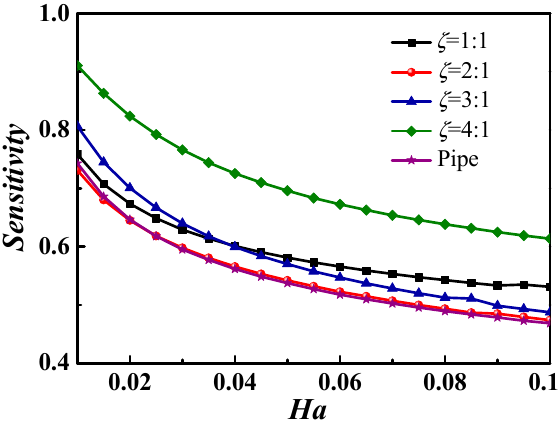
Figure 10. Sensitivity of the Vb number to the Nu number with various cross-sections. 3.4.3. Sensitivity Analysis of the Magnetic Direction At last, the sensitivity of the magnetic direction angle α on the Nu number is analyzed; the results are shown in Figure 11. When the angle α varies from 60° to 90°, the sensitivity coefficient of the Nu number increases obviously as the angle α increases, and reaches maximum at α = 70°. After that, the sensitivity coefficient decreases slowly. Therefore, the magnetic direction angle has the strongest adjustment ability to the Nu number at about 70°, and the larger direction angle (over 70°) has a stronger adjustment ability than smaller angles (below 70°). The sensitivity coefficient of different aspect ratios shows that the regulating ability of the magnetic direction on the Nu number with an aspect ratio of 4:1 is obviously better than that of other aspect ratios.